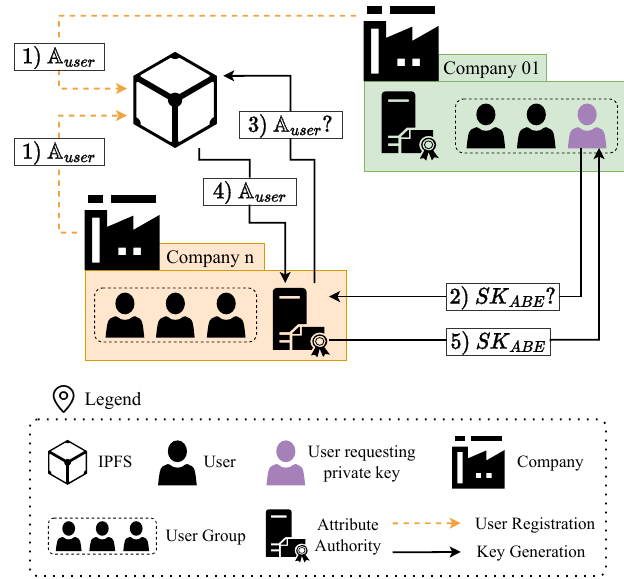
Figure 2. CP-ABE and dCP-ABE attribute storage in